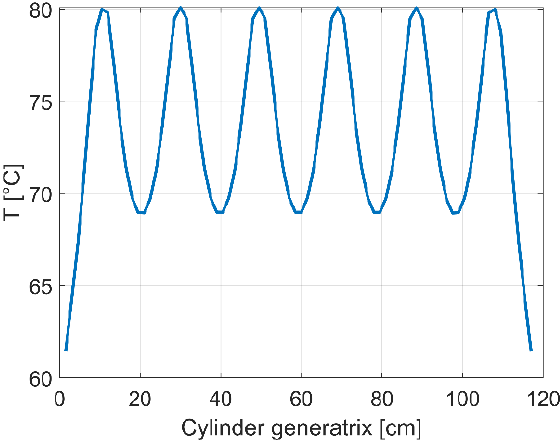
Figure 12. Temperature profile in the heat-steady state during temperature control with six inductors.